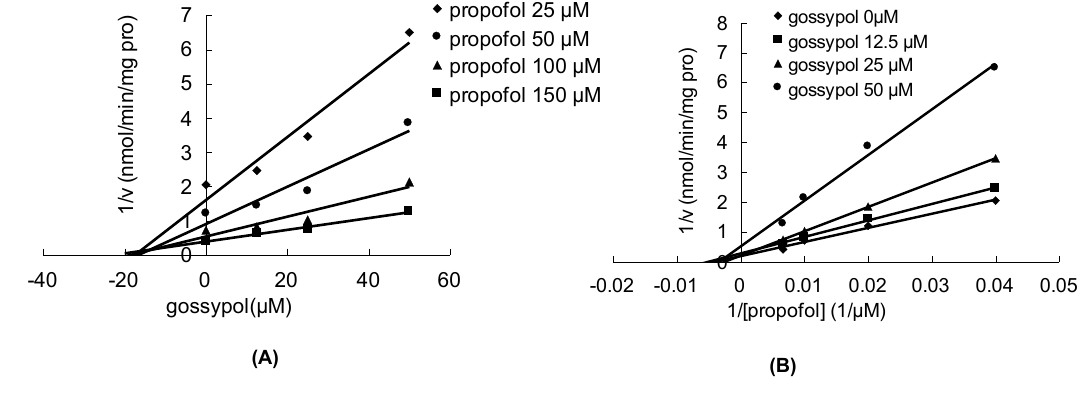
Figure 3. The inhibition of gossypol towards UGT-mediated propofol glucuronidation. ( A ) Dixon plot of the inhibitory effect of gossypol on UGT-mediated propofol glucuronidation; ( B ) Lineweaver-Burk plot of the inhibitory effect of gossypol on UGT-mediated propofol glucuronidation; ( C ) Second plot of slopes from Lineweaver-Burk plot vs . gossypol concentrations. All the experiments were carried out in